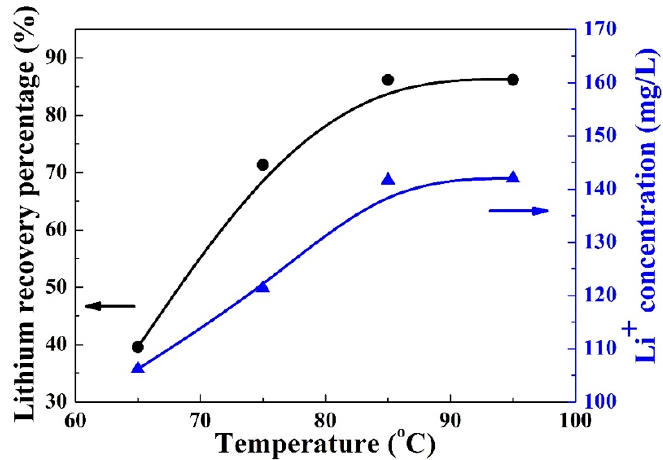
Figure 7. Lithium recovery percentage (round symbol) and Li + concentration in the filtrate (triangle symbol) from LiAl-LDHs-1 at varied recovery temperatures of 65 °C, 75 °C, 85 °C, 95 °C.